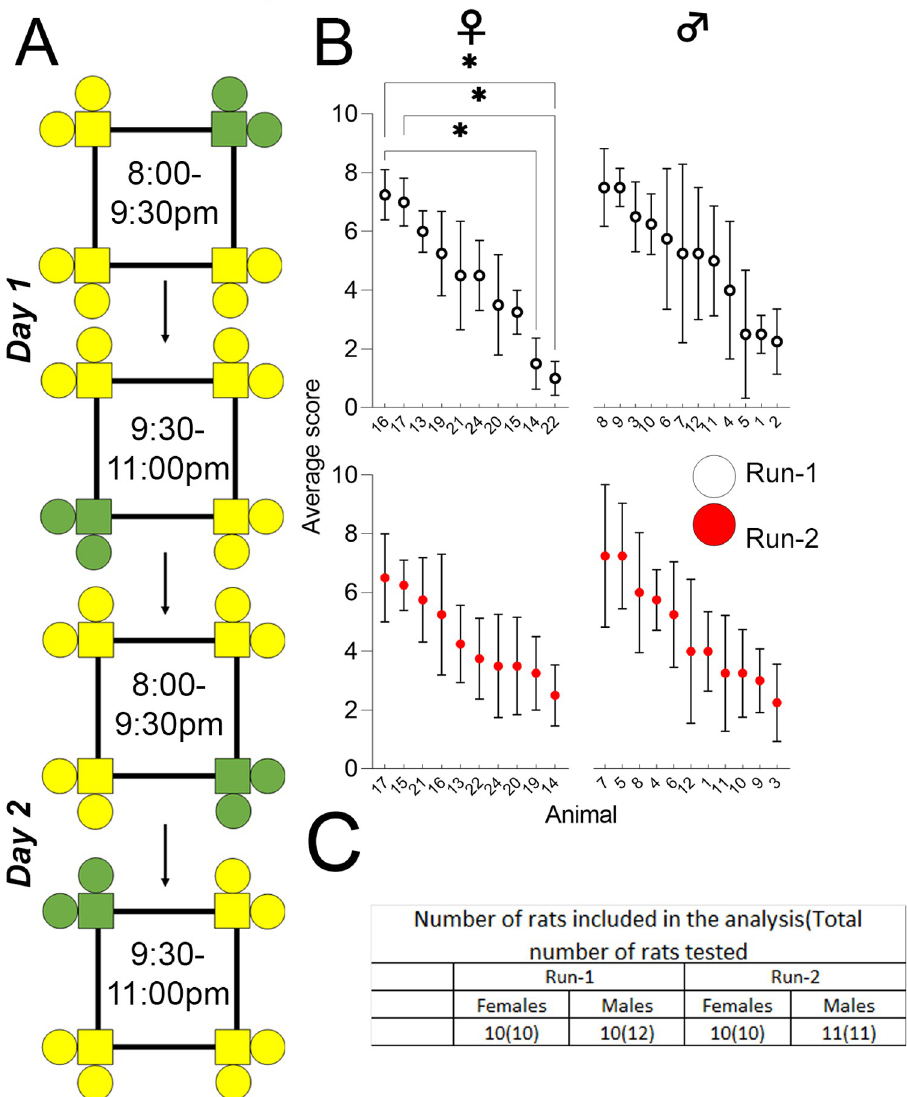
Fig 3. Single corner restriction, cohort B. (A) Single corner restriction (Cohort B only, 2 days). Progression of drinking (green) and non-drinking (yellow) corner layouts over two days. (B) Average scores for individual animals in cohort B by sex and Run, in decreasing order from left to right. Data points from Run-1 and Run-2 are indicated by white and red circles, respectively. All data represented as mean ± SEM ( � p < 0.05). See Table 3 for statistical analysis. ♀ = female, ♂ = male. n = 10 for females in both Runs. n = 12 for males in Run-1, while n = 11 for males in Run-2 due to death of one animal between Runs. were also significant session-wise increases in C-AUC for both sexes during Run-1, with no significant differences seen during Run-2 for either sex (Fig 5B). There were significant sex dif- ferences seen during Run-1, with C-AUC higher for males for all drinking sessions, but not during Run-2 (Fig 5C). For females, C-AUC was significantly higher during Run-2 compared to Run- 1 for the 1 st and 3 rd drinking sessions, with the value for the 2 nd drinking session being higher too but not reaching significance; there were no significant differences between runs for males (Fig 5D). Learning curves showed qualitative improvement, like those shown for place learning (Figs 4E and 5E).